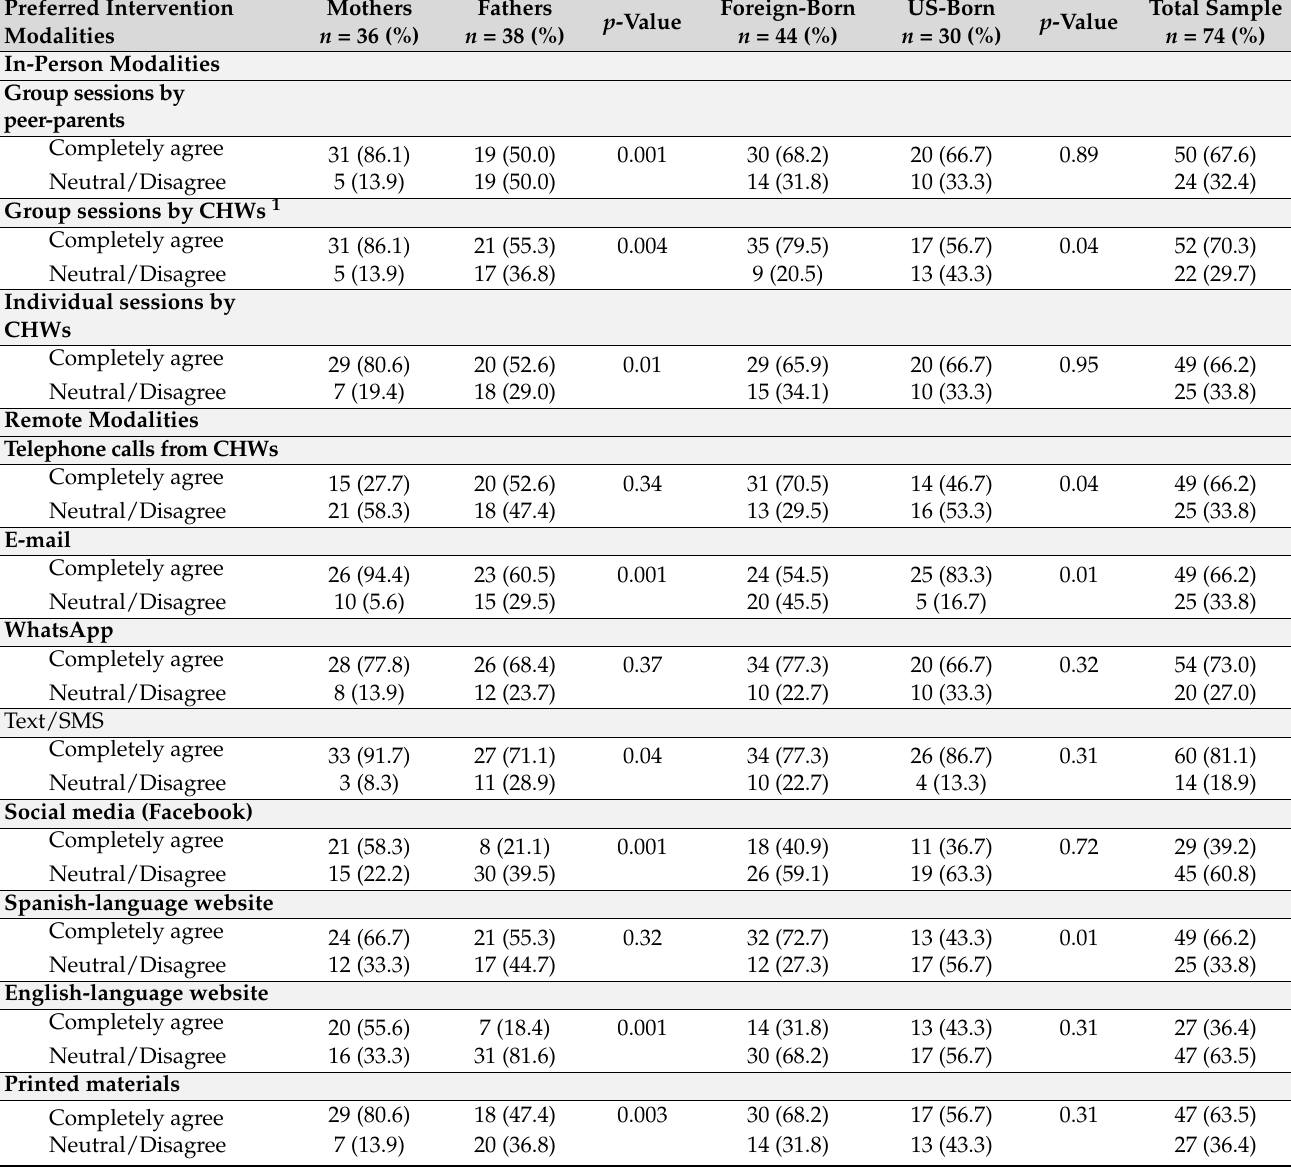
Table 3. Participants’ preferences for intervention modality for a family-based intervention to promote healthful energy balance-related behaviors of their preschool-aged children (2–5